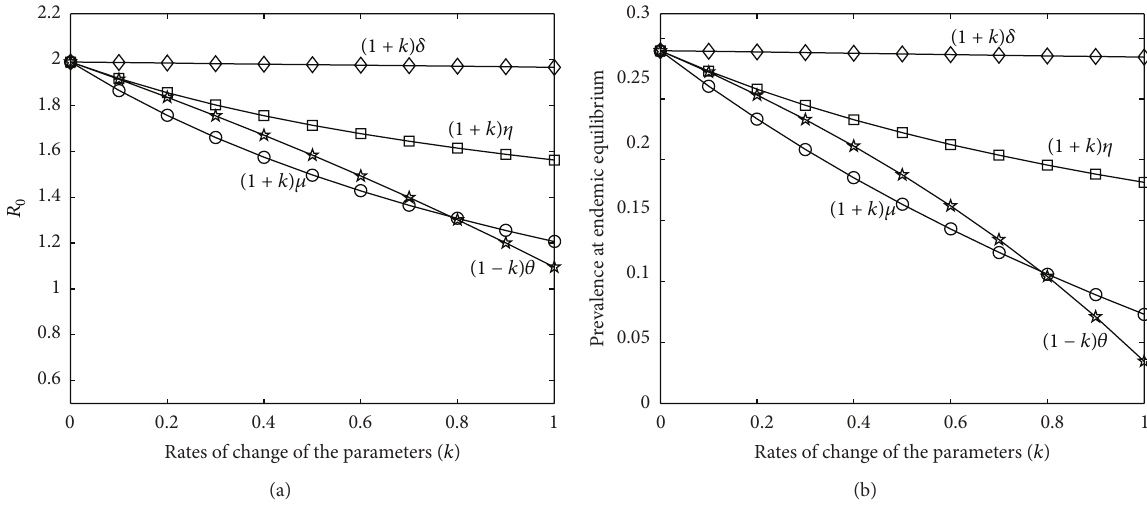
Figure 4: (a) Plots of the basic reproduction number 𝑅 0 by varying 𝑘 (the rates of change of 𝜇 ; 𝛿 ; 𝜂 ; and 𝜃 ); (b) plots of the prevalence at the steady state by varying 𝑘 (the rates of change of 𝜇 ; 𝛿 ; 𝜂 ; and 𝜃 ). Each column of markers denote that 𝑘 increases 10% per time. All the other parameters are as shown in Table 1.